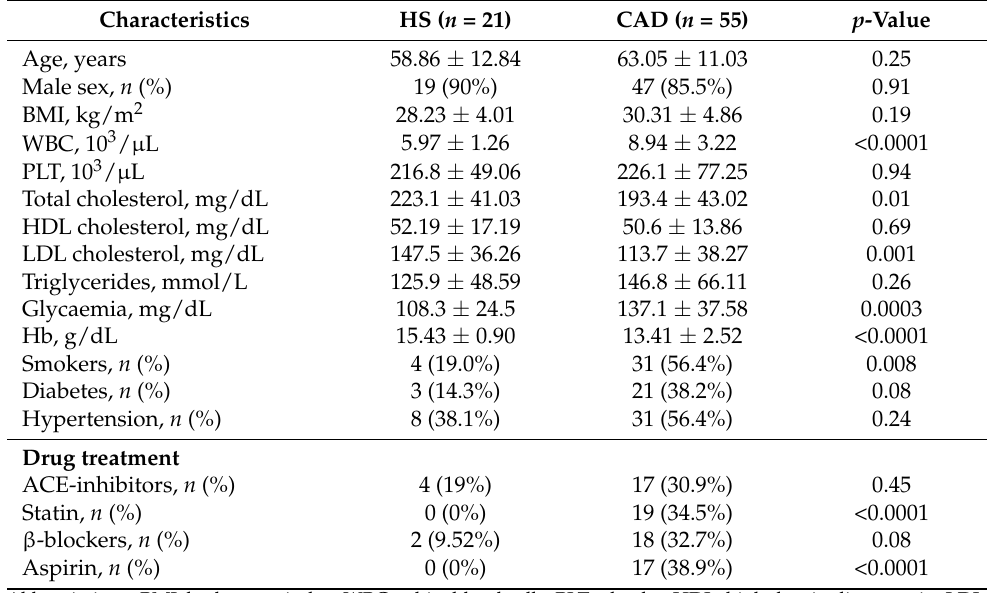
Table 1. Clinical and laboratory data in HS and CAD